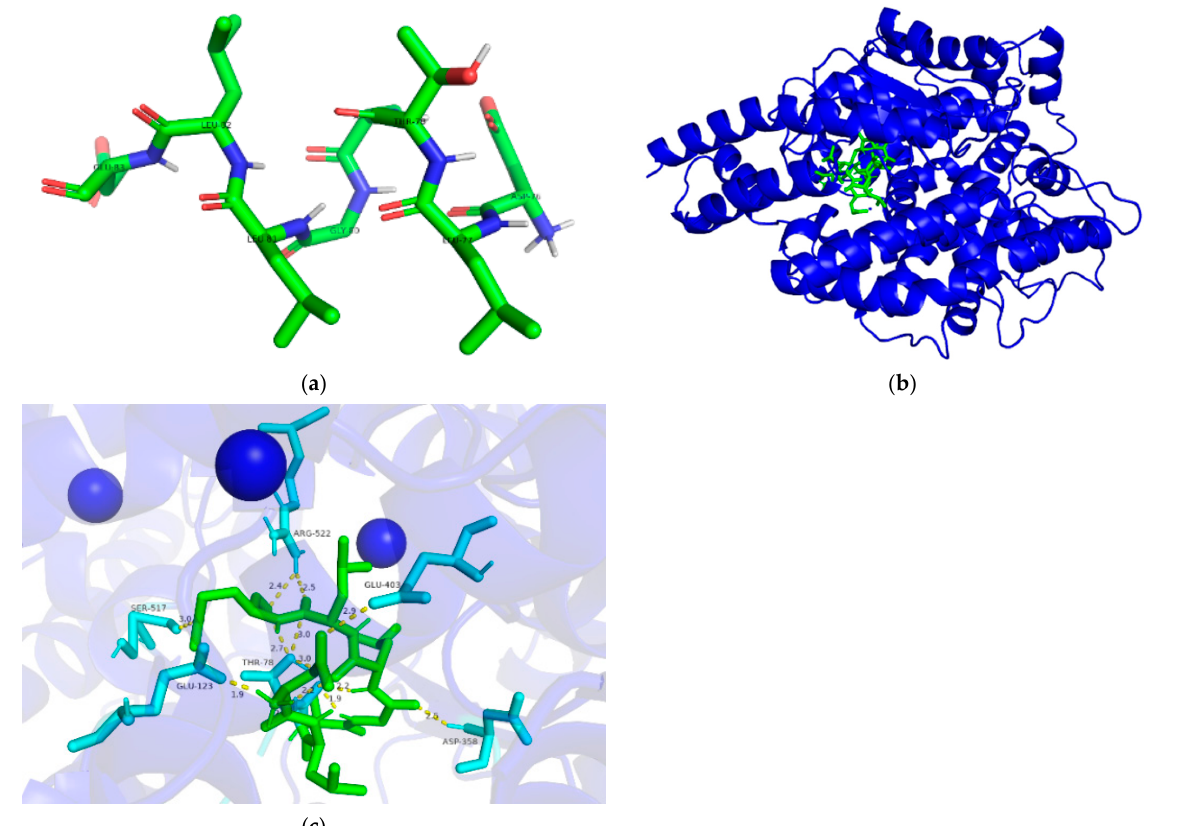
Figure 7. Molecular docking simulation of DLTAGLLE binding to ACE. ( a ) Structure of the peptide. ( b ) Docking diagram of DLTAGLLE (green) binding to ACE (shown as cartoon). ( c ) Interaction between DLTAGLLE (green) and residues of ACE (shown as sticks).